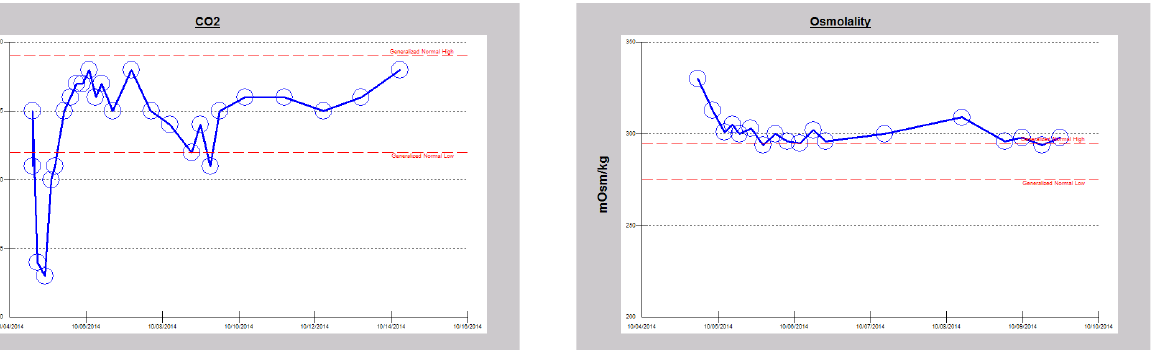
Figure 5. Trajectory of measured serum osmolality during the first 10 days of the admission with intentional ethylene glycol intoxication.